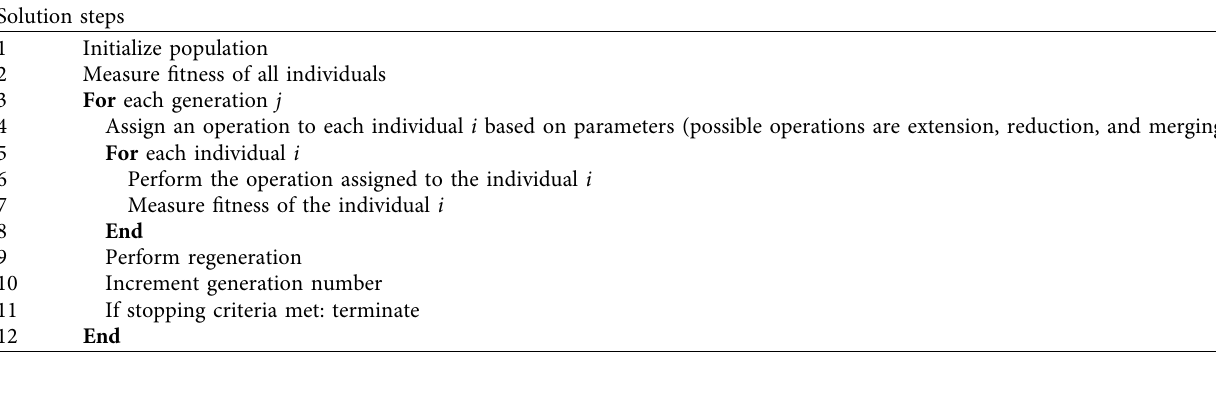
Table 2: Solution procedure.